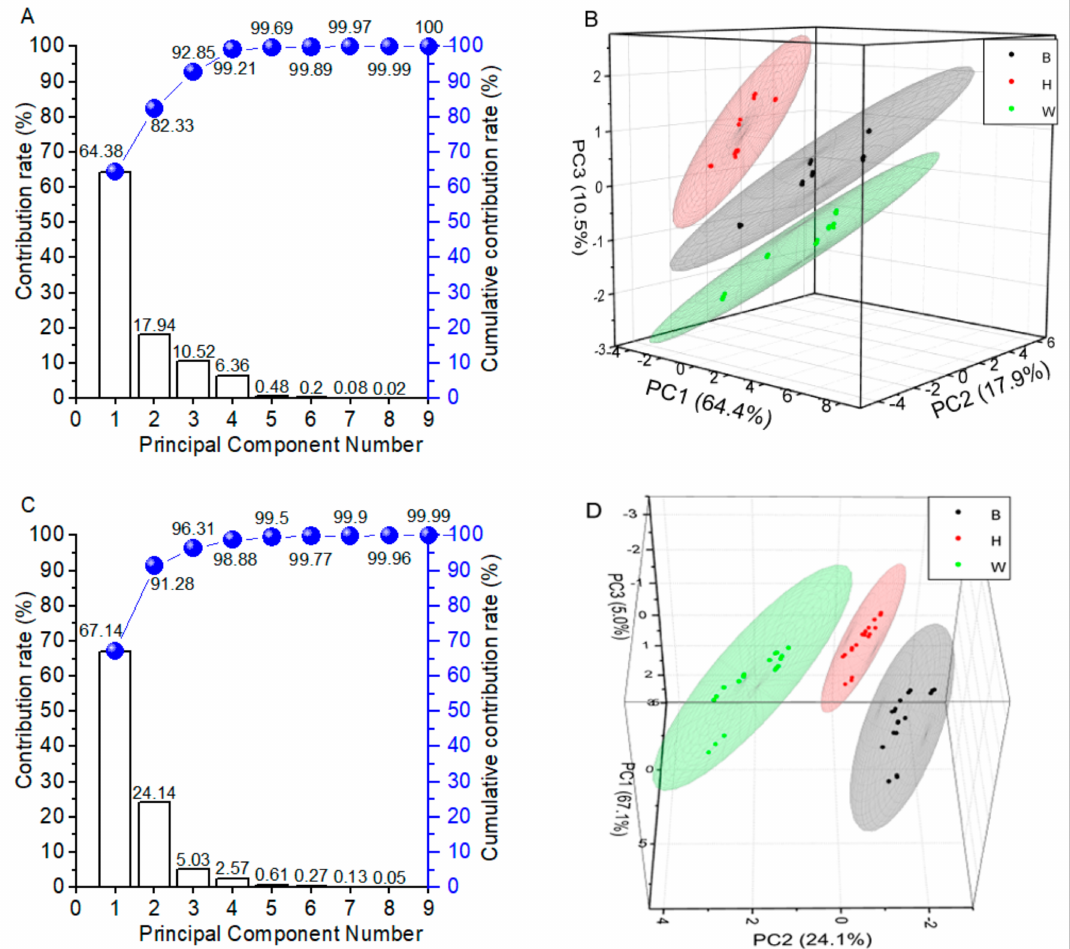
Figure 2. Principal component analysis (PCA) of egg yolks and albumen by electronic nose ( n = 18). ( A ) Contribution rate and cumulative contribution rate of yolks. ( B ) PCA score plot of yolks. ( C ) Contribution rate and cumulative contribution rate of albumen. ( D ) PCA score plot of albumen. B, Beinong No.2; H, Hy-Line Brown; W, Wuhei.